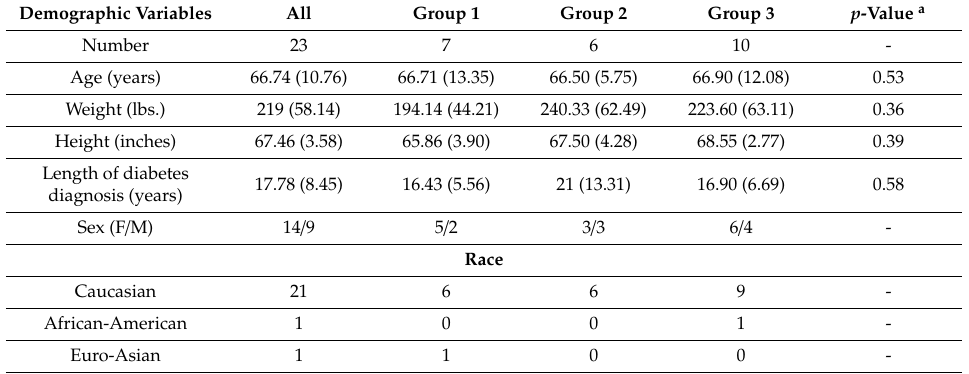
Table 1. Patient Demographics: Age, weight, height, and length of diabetes diagnosis are all listed as mean (standard deviation) while number, sex, and race are listed as